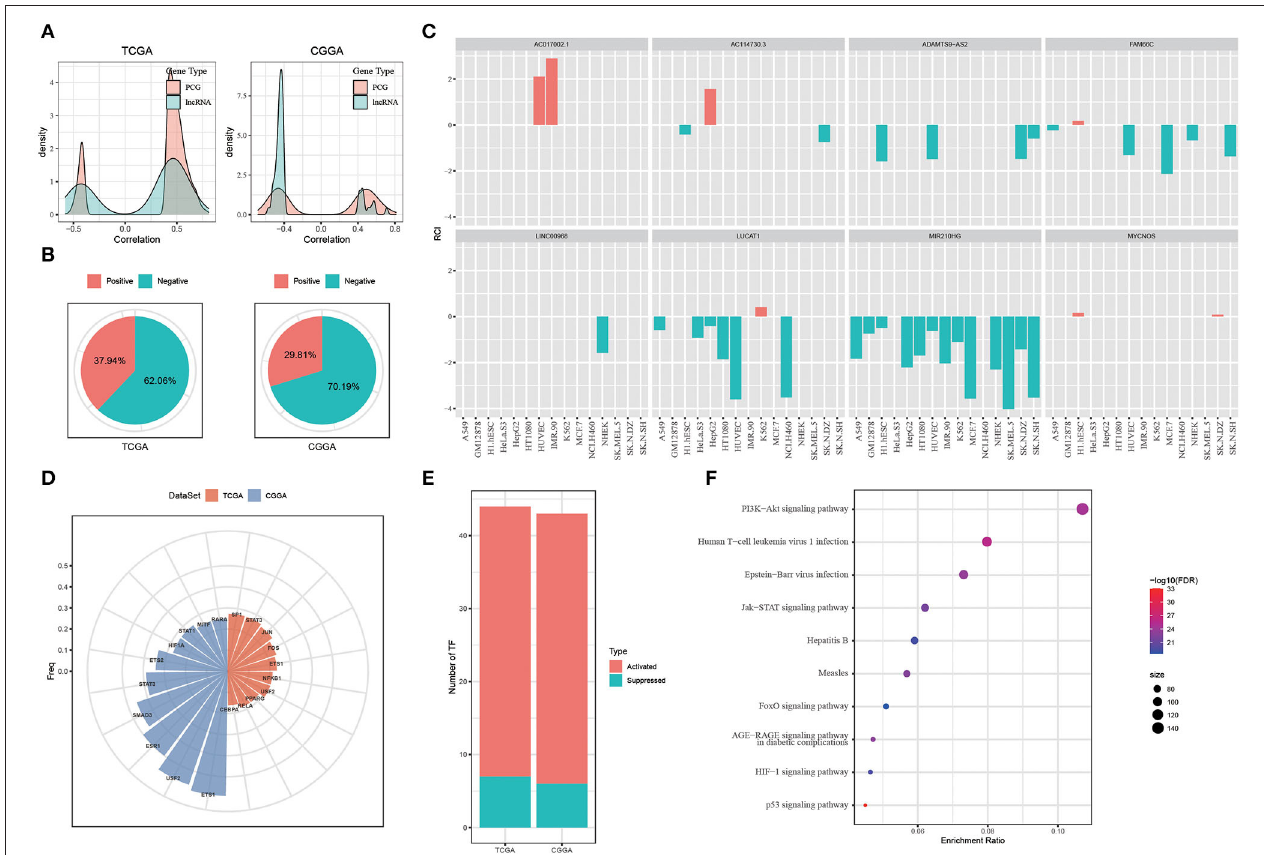
FIGURE 6 | Exploring the function of hypoxia-related long non-coding RNAs (lncRNAs). (A) Correlation between hypoxia-related lncRNAs and PCGs. (B) Location of hypoxia-related lncRNAs analyzed by LncATLAS. Positive indicates RCI > 0 and negative indicates RCI < 0. (C) The location of the 8 identified hypoxia-related lncRNAs. Red indicates RCI > 0 and green indicates RCI < 0. (D) The top 10 TFs negatively correlated to nuclear lncRNAs. (E) The number of activated and suppressed TFs by comparing C1 with C3. (F) The top 10 enriched pathways of upregulated TFs in C1 subtype. Size indicates gene